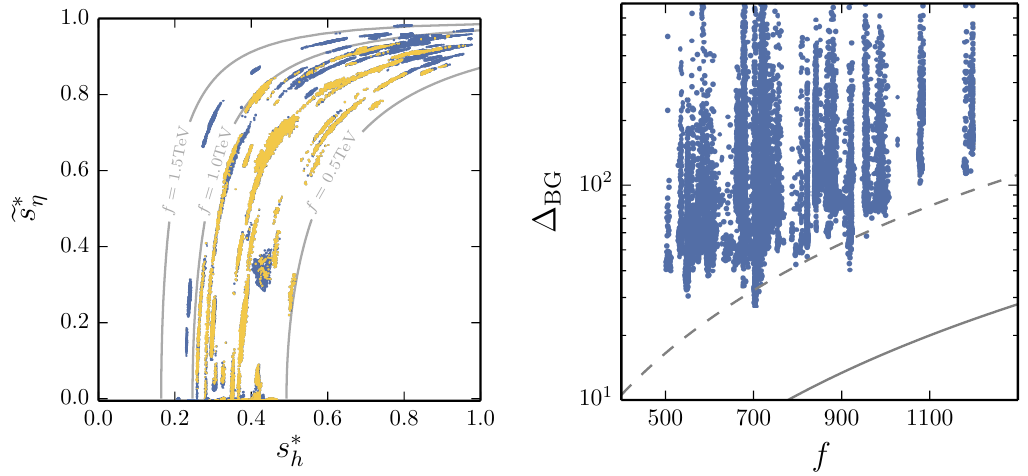
Figure 1 . Left: location of the minima of V e(cid:11) in the ( s (cid:3) h , e s (cid:3) (cid:17) ) plane found by the Markov chains. In gray there are lines of (cid:12)xed f where v SM = 246 GeV is realized. In yellow we mark the points with a good (cid:12)ne-tuning ((cid:1) BG < 100). Right: barbieri-Giudice measure (cid:1) BG of (cid:12)ne-tuning for ca. 40% of the viable points and its correlation with f . The gray lines show naive expectations for the (cid:12)netuning (see main